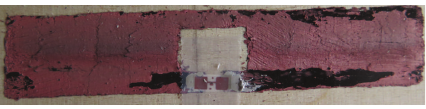
Figure 5: Burned areas on the antenna surface of Sample 6.